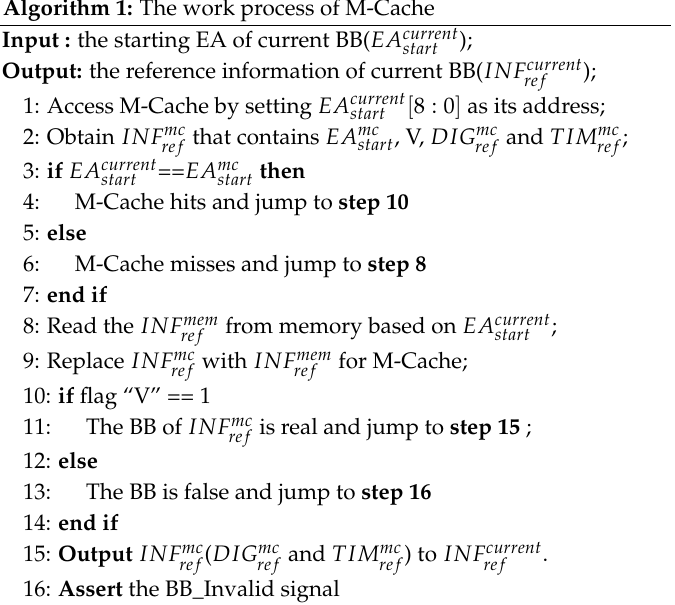
Algorithm 1: The work process of